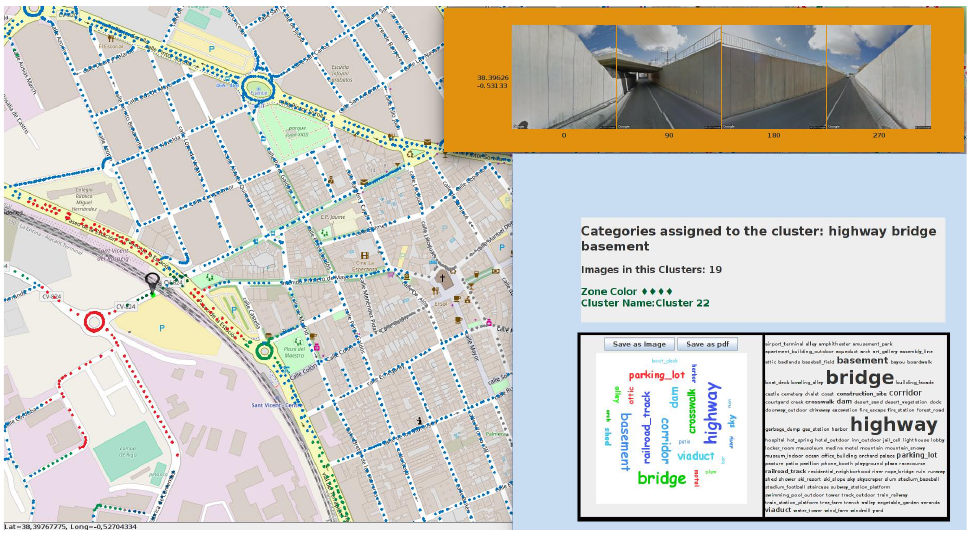
Figure 17. Example point in the map generated with the Average-BrayCurtis-0.6 combination, smoothed with K =